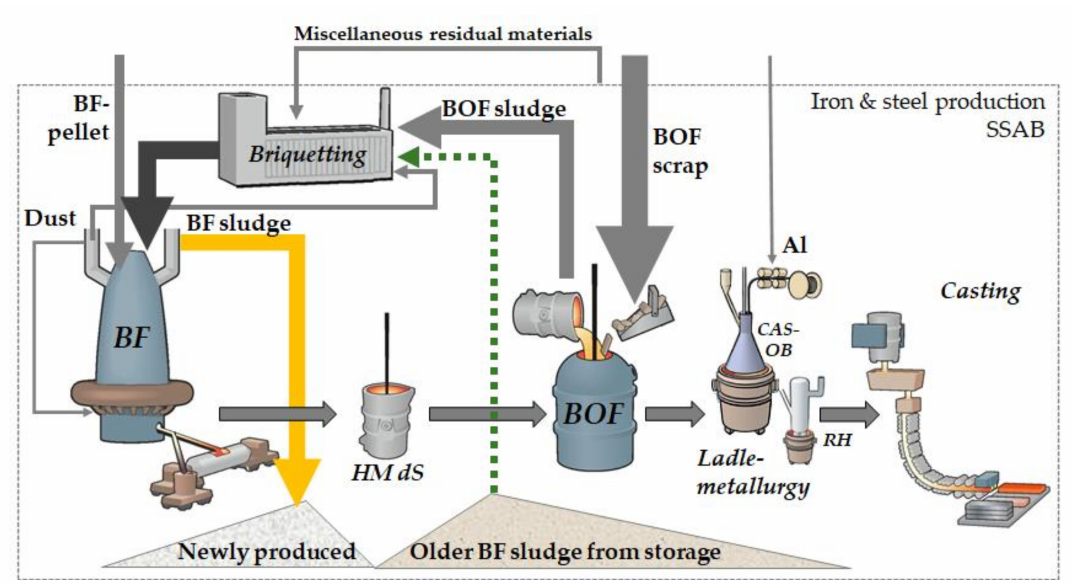
Figure 1. Schematics of the zinc flow in the iron and steel production route at SSAB Europe,